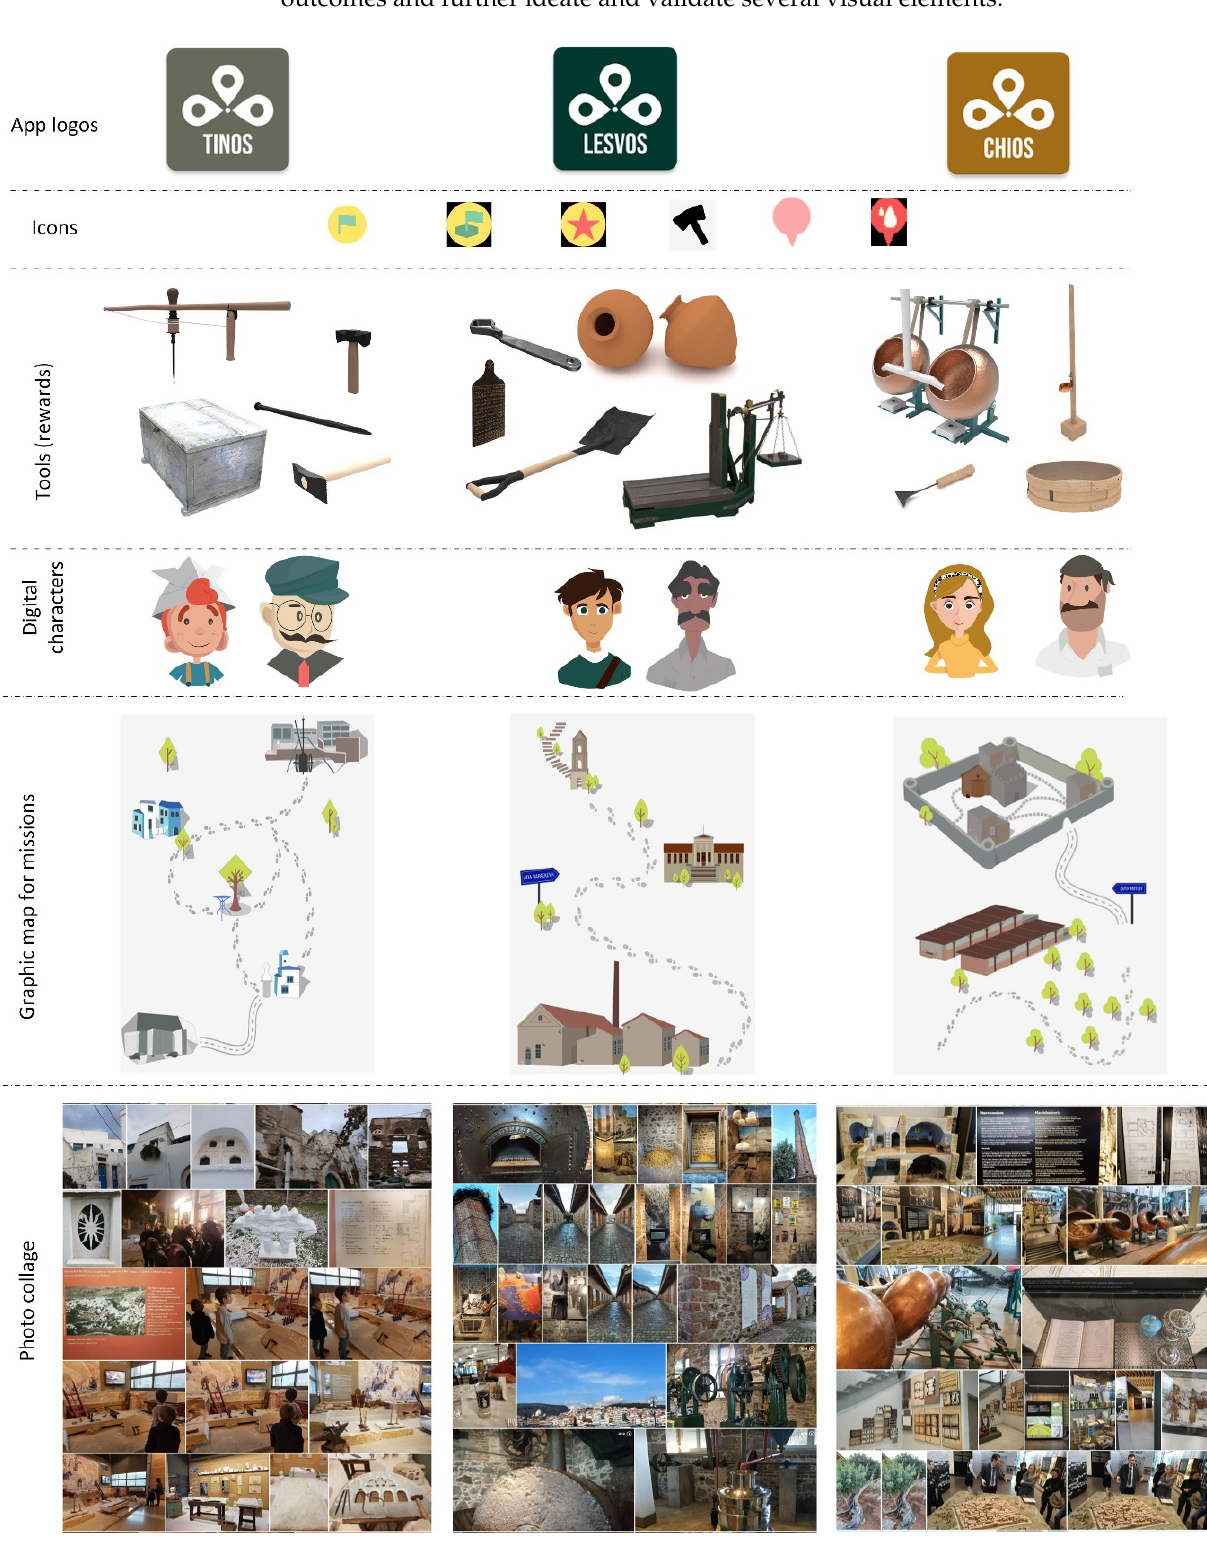
Figure 4. Visual elements produced at the ideation phase: app logos, icons, graphics for tools, mission maps; and photo collages used for